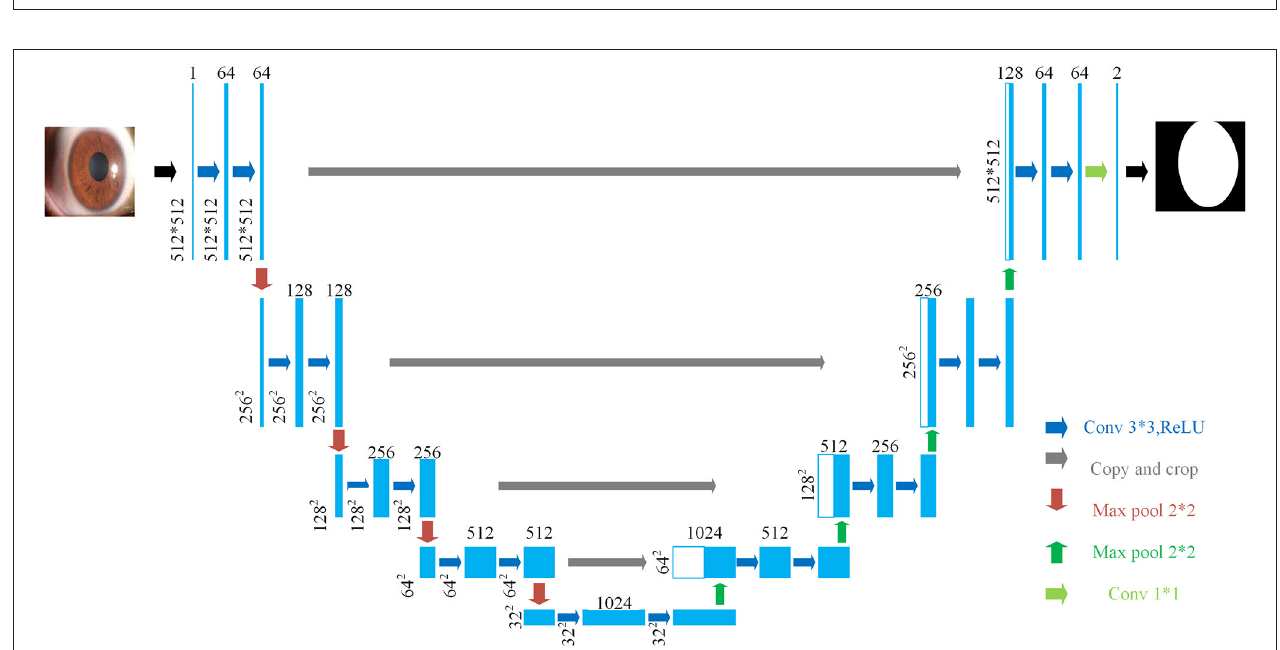
FIGURE 2 | Framework of the system for measuring pathological progress of pterygium.